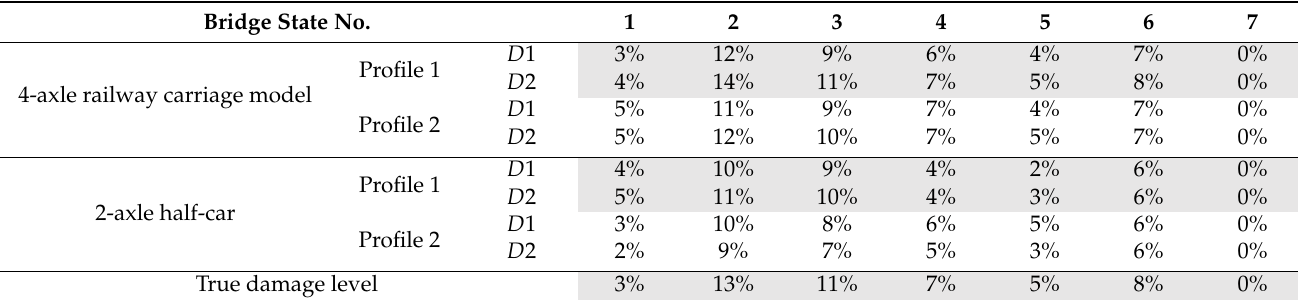
Table 5. Inferred and true damage levels.